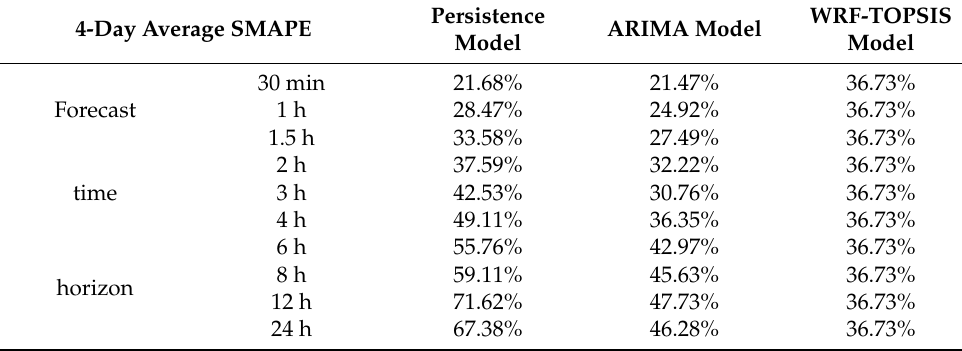
Table 12. Four-day average symmetric mean absolute percentage error for the wind speed forecasting using the persistence, ARIMA, and WRF-TOPSIS models applied to the 4-day test